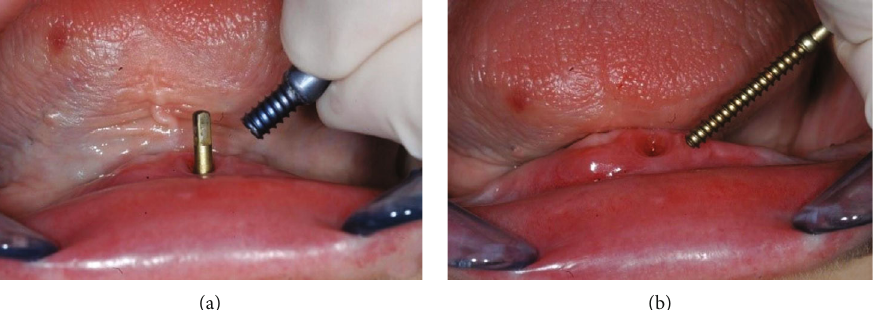
Figure 4: (a) Simple removal of the left-hand threaded hollow screw. (b) Easy removal of the right-handed distraction screw leaving a tiny hole in the mucosa, which subsequently healed.